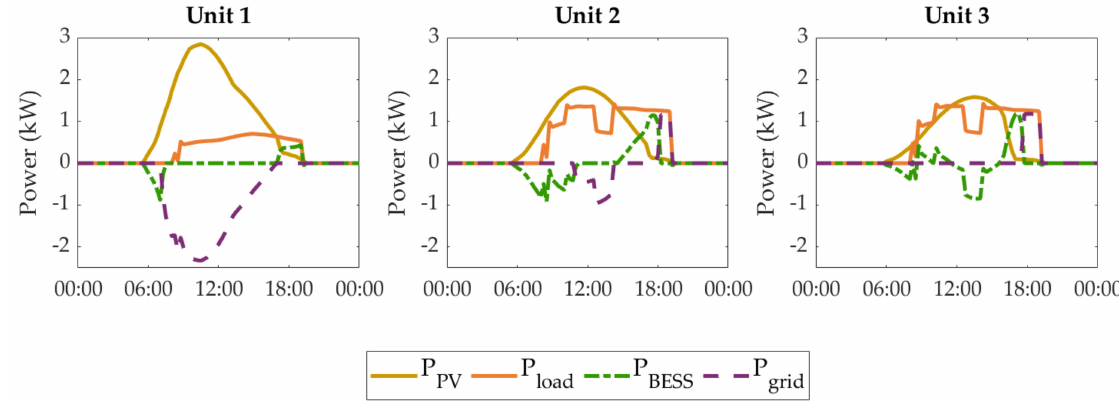
Figure 11. Power profiles of PV generation, electrical load, BESS charge/discharge and grid absorptions/injections during a typical summer day for the three units.